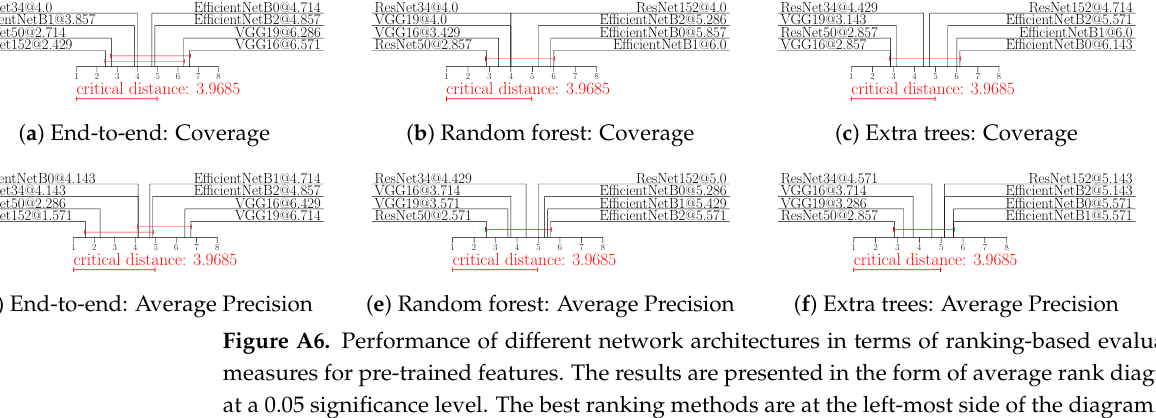
Figure A5. Performance of different network architectures in terms of example-based evaluation measures for pre-trained features. The results are presented in the form of average rank diagrams at a 0.05 significance level. The best ranking methods are at the left-most side of the diagram. The difference among the methods connected with a red line is not statistically significant.